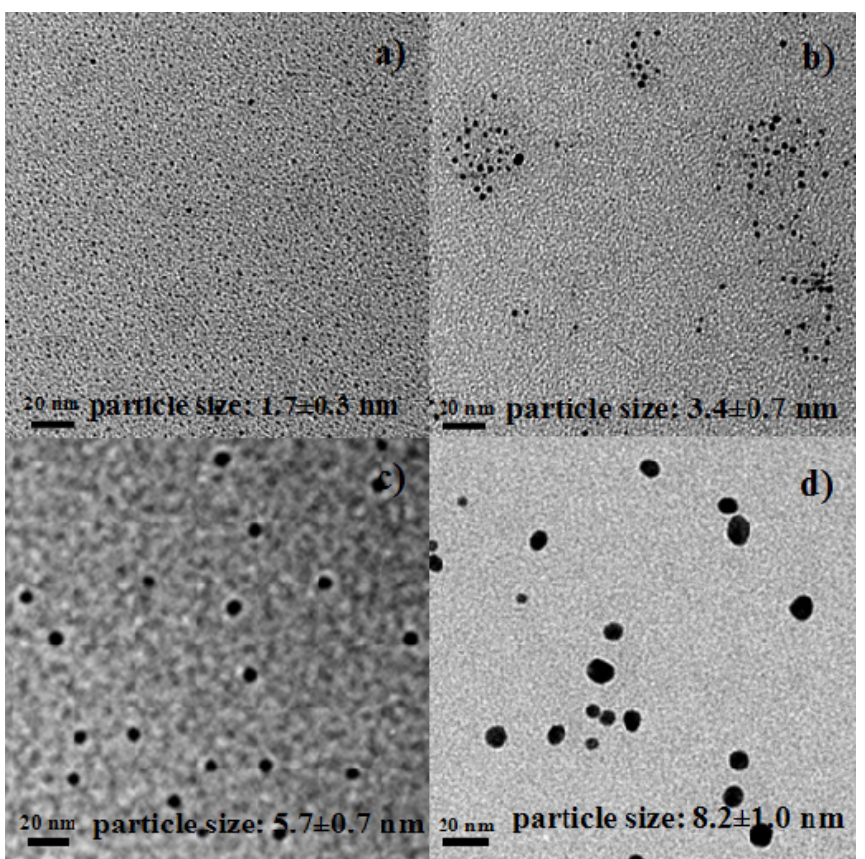
Figure 1. TEM images of Au NPs synthesized by mixing 0.06 mmol HAuCl . ( a ) 0.4 mmol; ( b ) 0.5 mmol; ( c ) 1.0 mmol; and ( d ) 1.1 mmol different amounts of NaBH 4 NaBH . Scale bars are 20 nm. 4